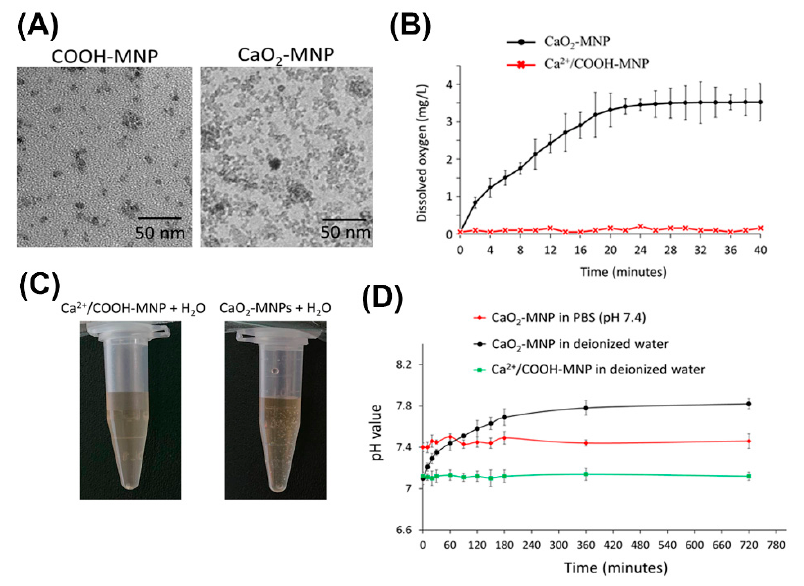
Figure 4. Chemical and physical characteristics of calcium peroxide-modified magnetic nanoparti- cles (CaO 2 -MNPs). ( A ) TEM images of COOH-modified MNPs (COOH-MNPs) and CaO 2 -MNPs. The used solvents for preparing TEM samples of COOH-MNPs and CaO 2 -MNPs were water and polyethylene glycol (M.W. 200) (PEG200), respectively. ( B ) dissolved oxygen kinetics after the ad- dition of Ca 2+ /COOH-MNPs or CaO 2 -MNPs (0.1 mL; Fe concentration: 0.9 mg/mL) into 20 mL of water at room temperature. ( C ) optical photographs of Ca 2+ /COOH-MNPs and CaO 2 -MNPs incu- bated with water. ( D ) the pH value profiles after addition of Ca 2+ /COOH-MNPs and CaO 2 -MNPs (0.1 mL; Fe concentration: 0.9 mg/mL) in 20 mL of PBS buffer (pH 7.4) or water at room tempera- ture.